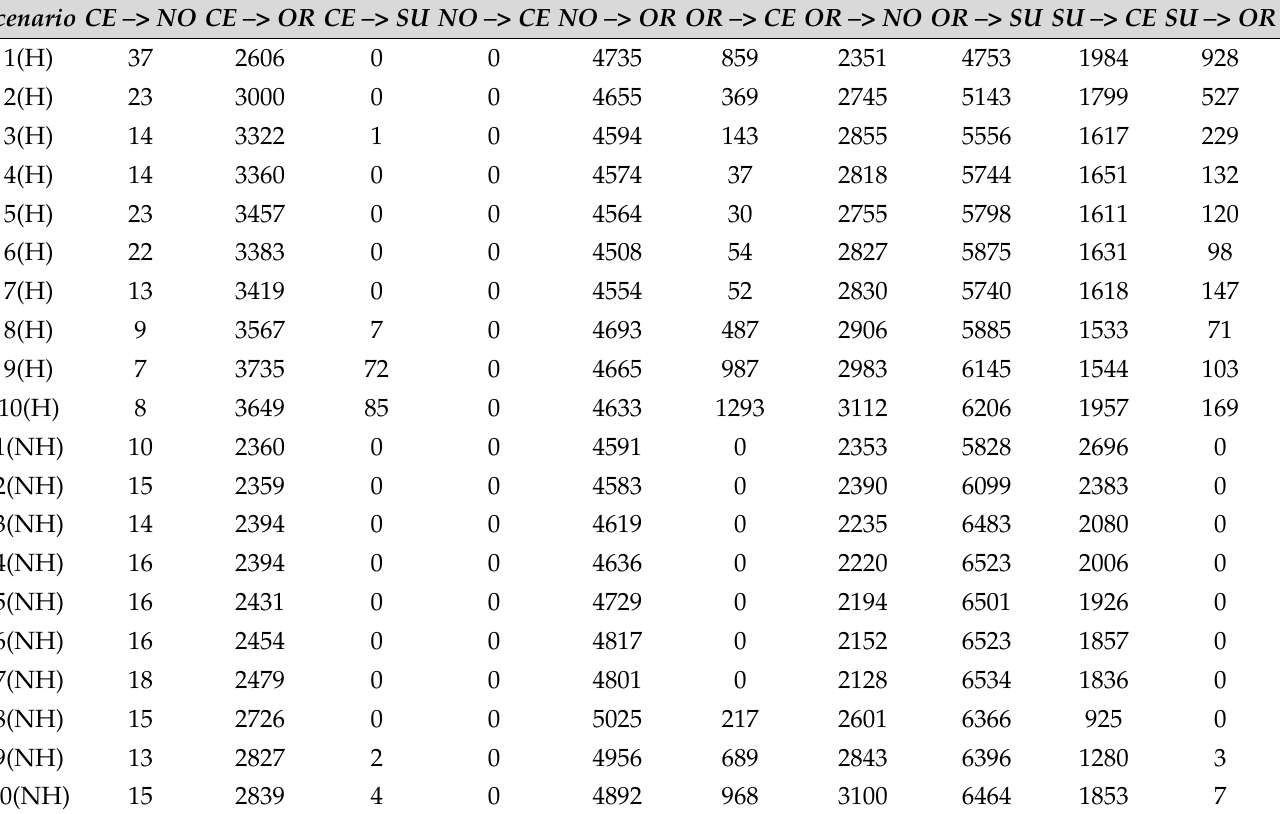
Table 9. Number of hours of congestion in each